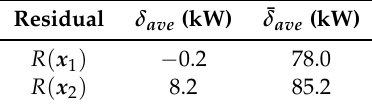
Table 2. Statistical behavior of the residuals between measurement and estimation, for the different random choices of the D0 and D1 data